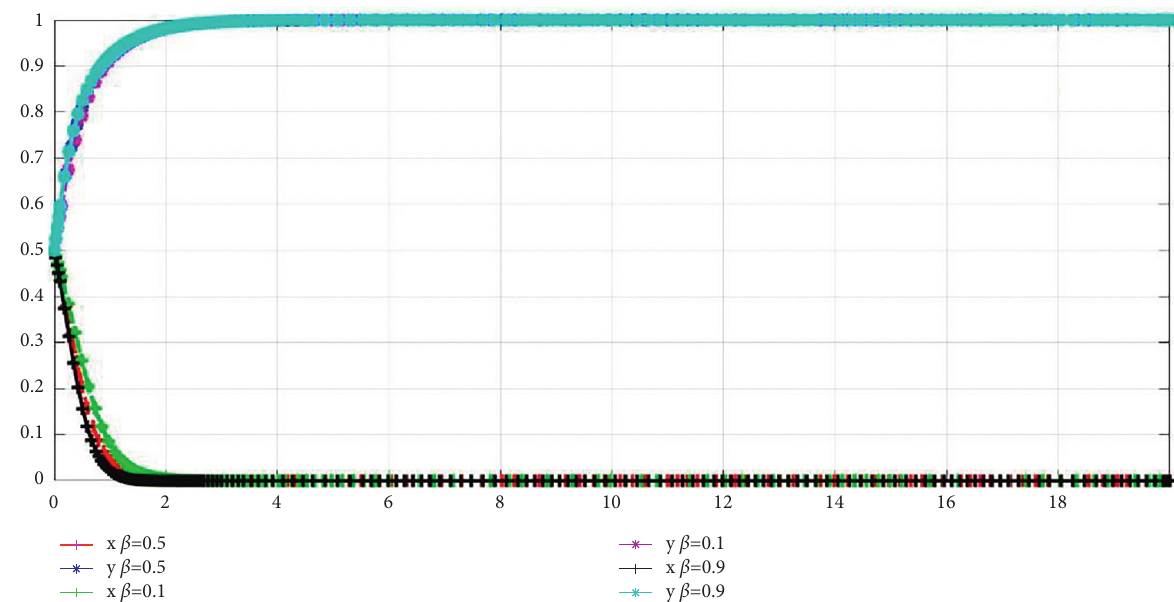
Figure 8: Evolution track of different environmental policy intensities.